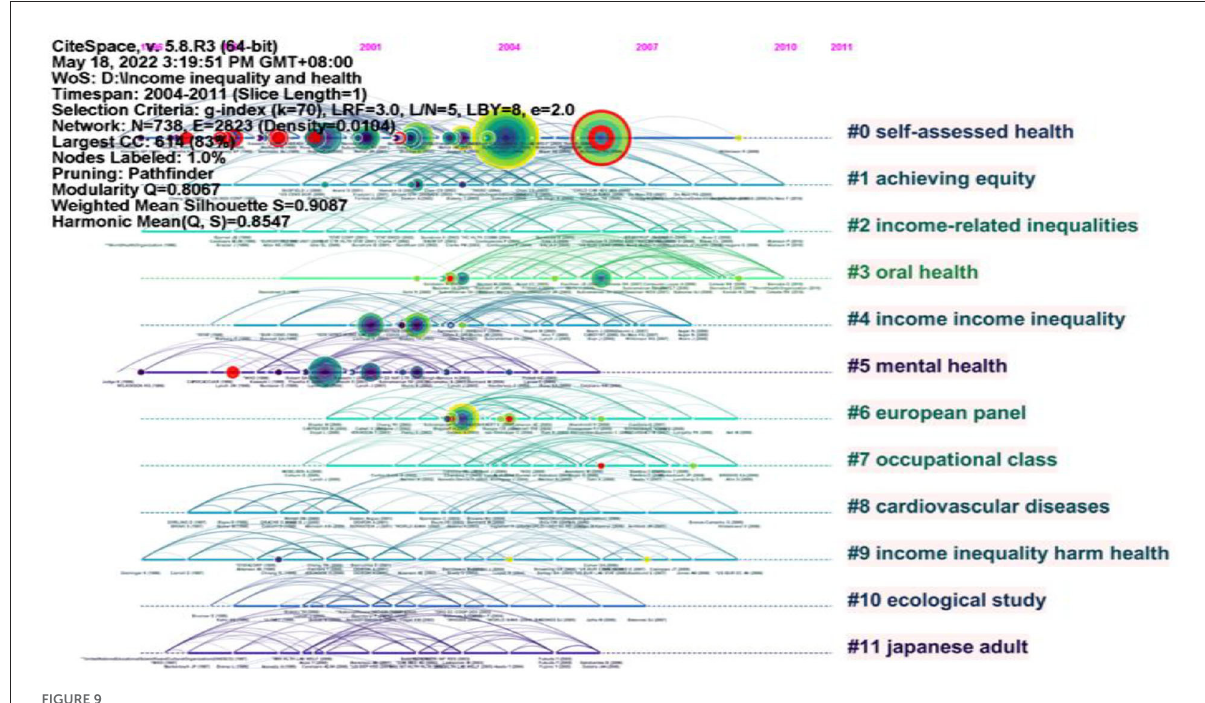
FIGURE9 Timeline visualization of clusters in